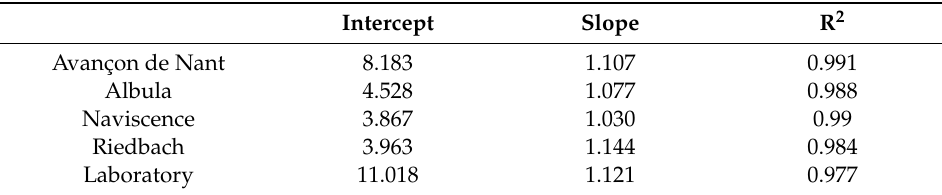
Table 5. Regression coe ffi cients of the relationship between the impact kinetic energy derived from laboratory experiments, and the recorded direct A max , for all the impact tests over all the plates (taken together) at the Avançon de Nant, Albula, Naviscence, and Riedbach measuring stations, respectively, and the results for the corresponding laboratory